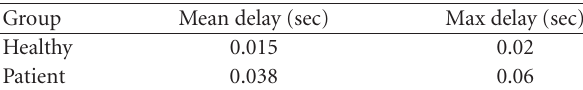
Table 3: Delay in autonomic response for two